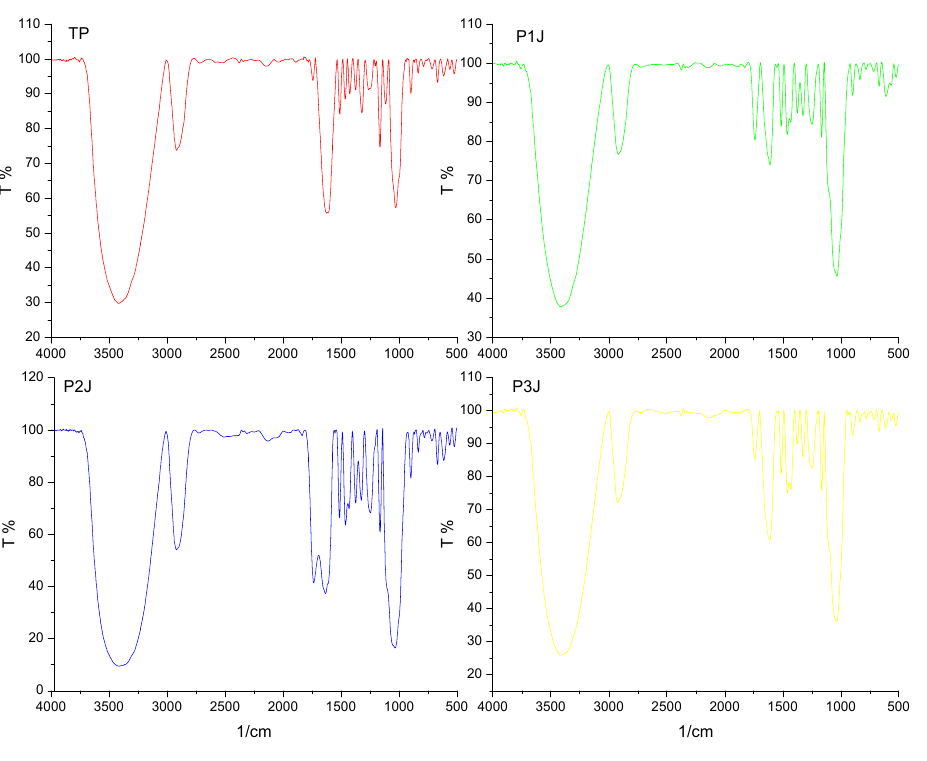
Figure 9. FTIR test of BSFs (TP, P1J, P2J, and P3J). The graph of the FTIR test results shows differences in the composition of fiber compounds where the functional groups O-H, C-H, C=O, C=C, and CH 3 look different; this indicates that the treatment of fiber with liquid smoke affects the change in wave crest. Figure 10 is a combination of the FTIR BSFs transmittance pattern TP, P1J, P2J, and P3J, where the shape of the peak on the graph changes due to the liquid smoke treatment. The constituent molecules in the FTIR Spectrum show that the wave peaks numbered from 2500–4000 cm − 1 are in the O-H and C-H spectra and caused a significant addition of P2J BSFs composition. The peak wave number 1500–2000 cm − 1 is in the spectrum C=O and C=C, which indicates that the BSFs compound increased in intensity after treatment, and the compound content was more significant than BSFs without treatment. Therefore the liquid smoke can add C=O and C=C compounds to the chain of BSFs compounds such as lignin and hemicellulose, and the high carbon composition of BSFs can increase their strength of BSFs. While at the peak of the wave number 500–1500 cm − 1 is in the CH 3 spectrum, which indicates the addition of CH 3 composition, P2J BSFs become the most significant increase in functional